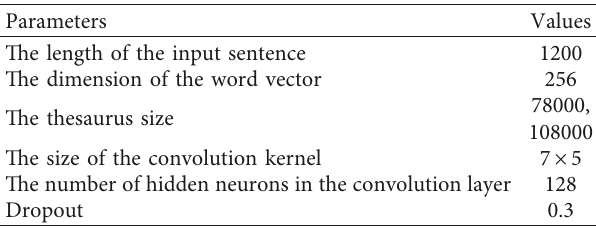
Table 3: Parameters of the model.